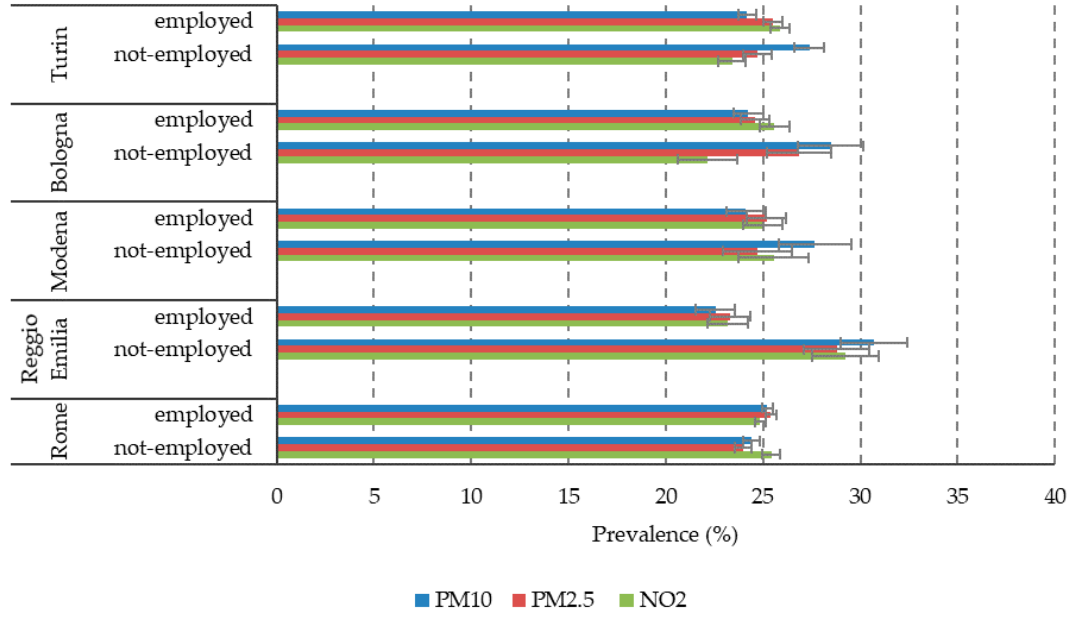
Figure 2. Prevalence of high air pollution exposure ( > 75th percentile) by city and maternal occupation.